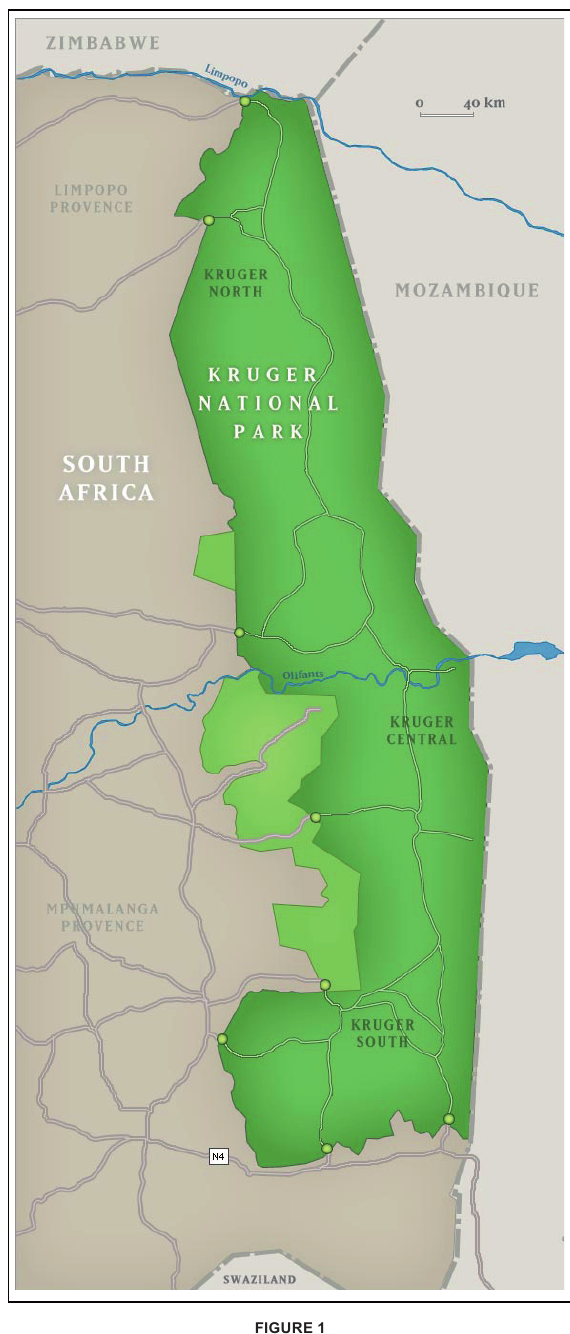
Figure 1 Kruger National Park (Source: African Safari Travel,